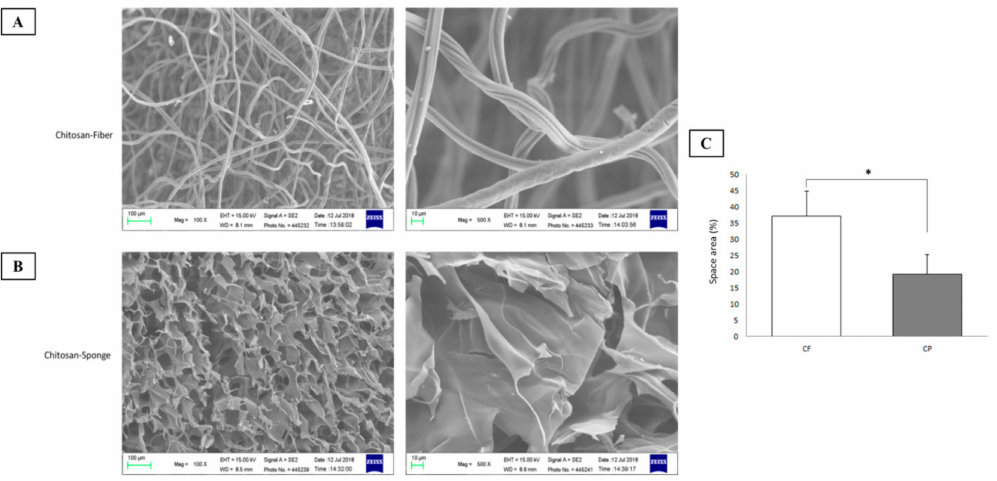
Figure 2. Morphology of chitosan-based dressings. ( A ) Chitosan fiber dressing. ( B ) Chitosan sponge dressing. ( C ) Surface area of dressings. (CF, chitosan fiber; CP, chitosan sponge), *p < 0.05.